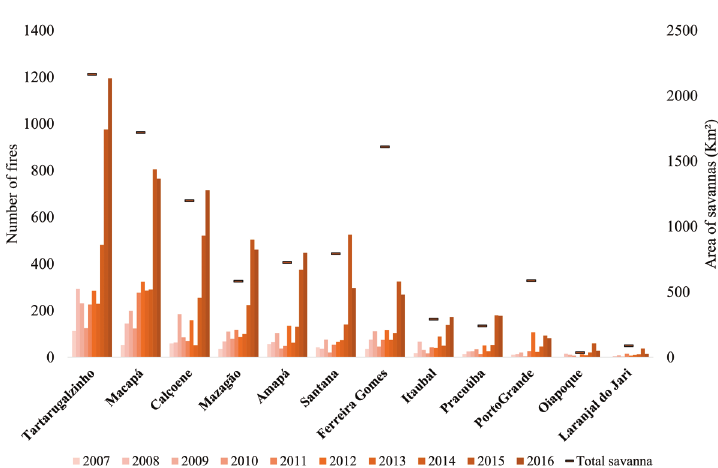
Figure 4. Fire in the Cerrado of Amapá, 2007 – 2016. Total number of hot pixels between 2007 and 2016, and total area of savanna habitats per municipality, in order of total number of outbreaks between 2007 and 2016. The hot pixels were quantified from shapefiles of the occurrence of burns obtained from the databases of the Instituto Nacional de Pesquisas Espaciais (INPE) (https://prodwww-queimadas.dgi. inpe.br/bdqueimadas/). Based on these shapefiles, and using ArcGIS v10.4.1 (ESRI 2011) the total num- ber of hot pixels per year and per month within the Cerrado of Amapá were quantified in accordance with the Brazilian Institute of Geography and Statistics vegetation cover map for the Amazon (IBGE 2004a) and overlaid with the municipality boundaries available from the Amapá State Environmental Secretariat (SEMA-AP 2016). The area of savanna habitats was quantified as described in the legend of Figure